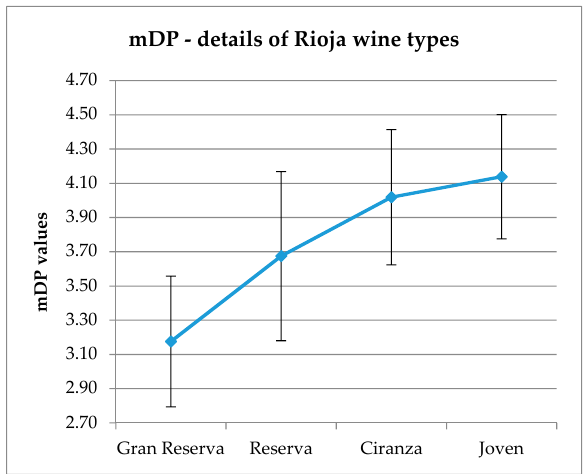
Figure A3. Mean degree of polymerization distributed by Rioja wine “types”. Error bars are standard deviation of wine samples within each